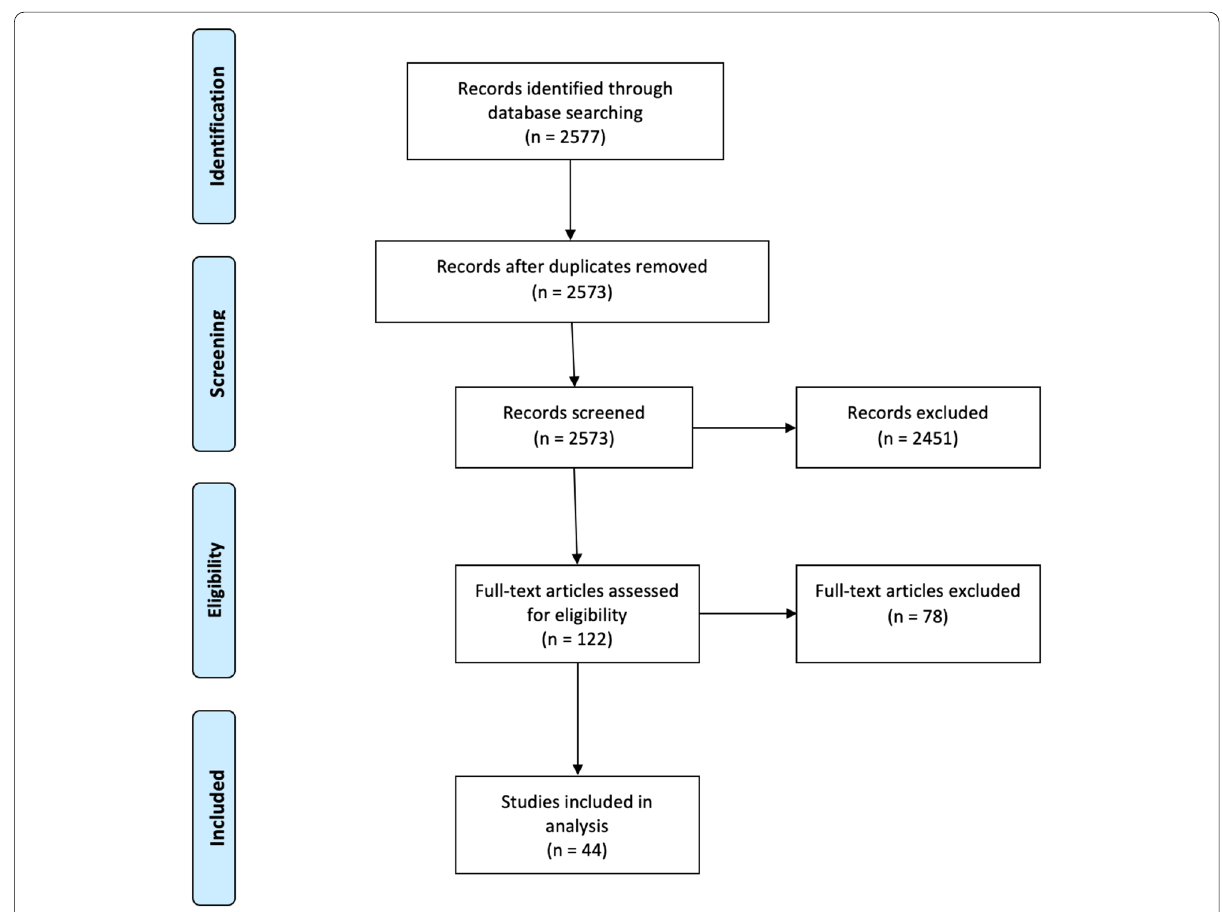
Fig. 1 PRISMA study selection